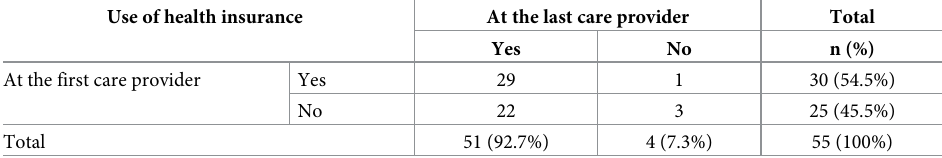
Table 4. Health insurance use among insured or government aid beneficiaries who went to multiple providers (n =